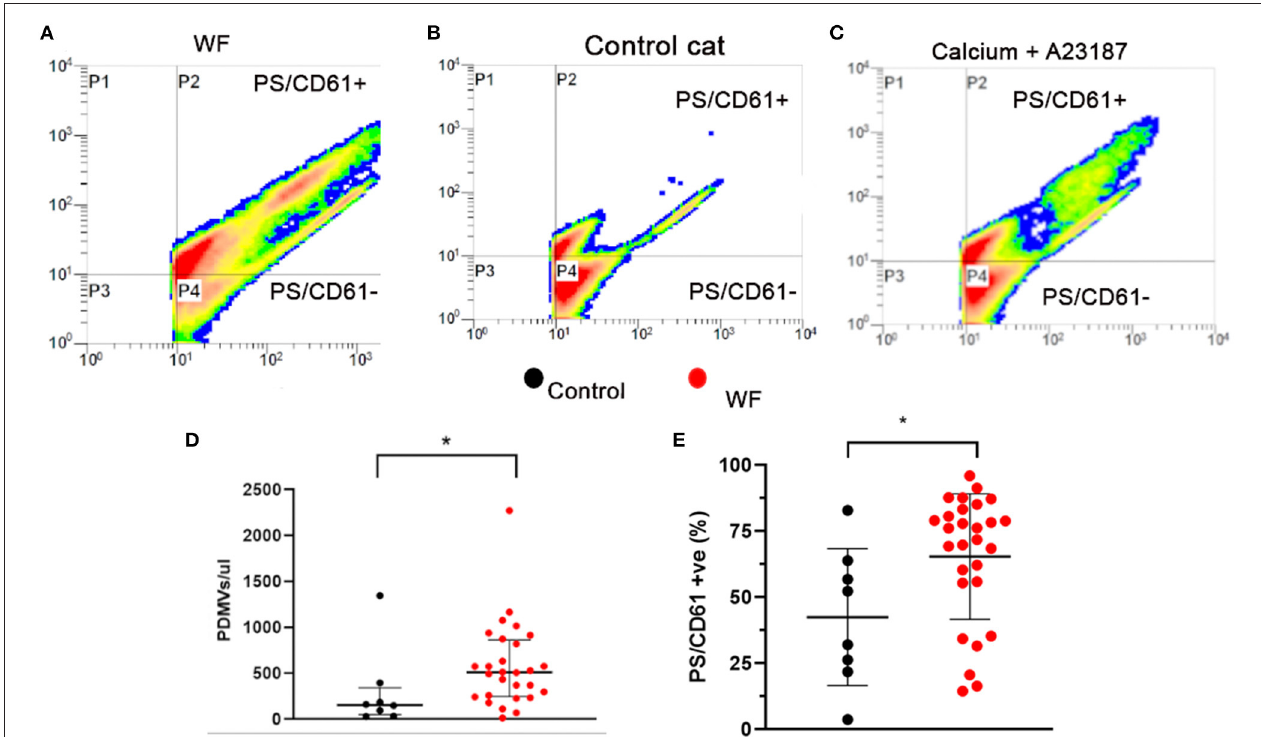
FIGURE 6 | Cats with naturally occurring wildfire injuries (WF) had elevated circulating platelet-derived microvesicles (PDMV). PDMV was measured in platelet poor plasma in 29 WF cats and 8 healthy control cats by flow cytometry. (A–C) Representative scatter dot plot diagrams of flow cytometric analysis of PDMV identified based on size, side scatter properties and co-expression of integrin β 3 (CD61) and phosphatidylserine (PS) – P2. (A) Representative scatter plot generated from a cat with wildfire-related injuries, (B) from a control cat without hypertrophic cardiomyopathy and (C) positive control generated by activating platelets with 2mM calcium and the calcium ionophore, A23187 (2.5 µ M), which showed a significant increase in PDMV compared to resting sample. (D,E) WF cats not only had increased number of PDMV but a greater percentage of them had externalized PS compared to healthy controls. * p <